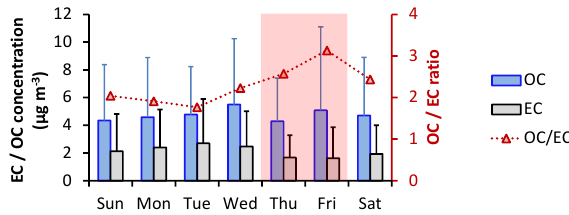
Figure 6. Day-of-week variation in OC (µgm − 3 ) , EC (µgm − 3 ) , and the OC / EC ratio during the observational period. The shading days (Thursday and Friday) were the weekends in Saudi Arabia in 2012.